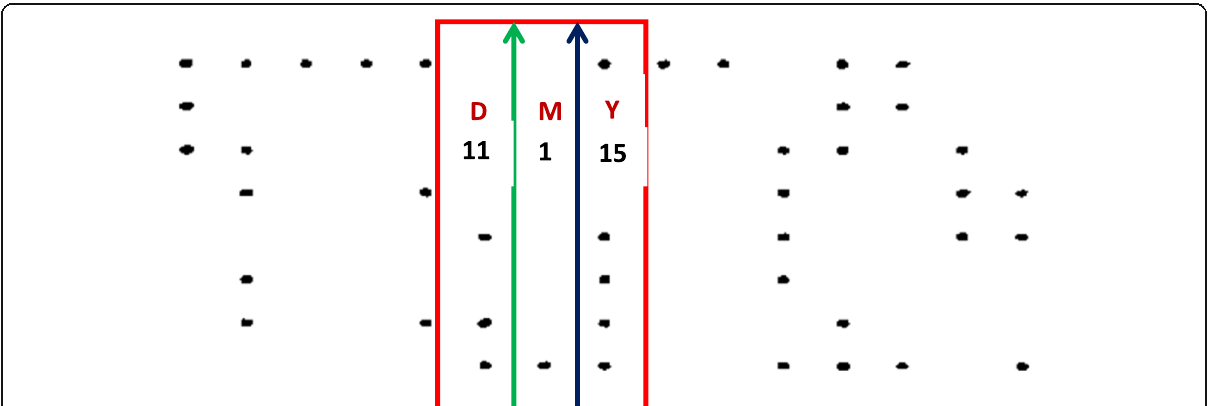
Fig. 10 The exhibition of the day, Month, and year (D, M, and Y) calculated, 11/1/2015 in the grayscale mode of a coded dots matrix embedded in a color laser printout of Xerox®